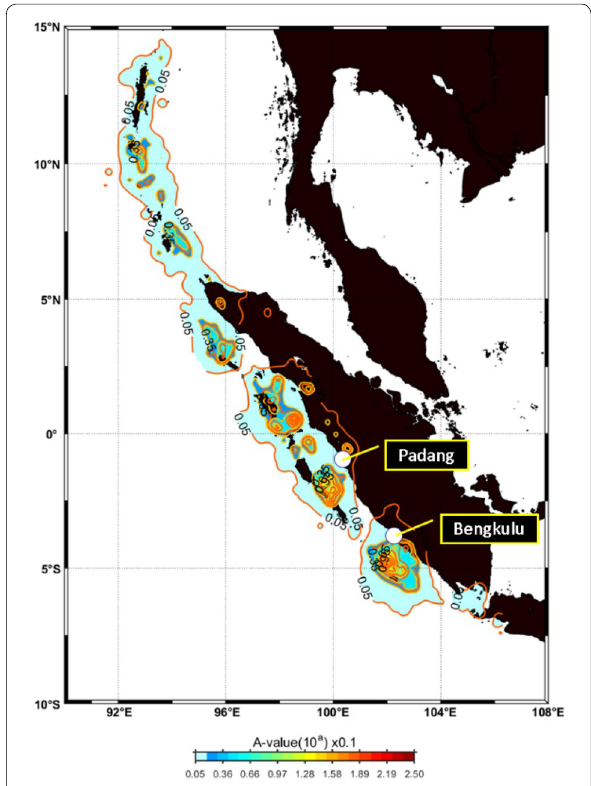
Fig. 2 The A -value model, estimated by product of normalized seismic moment rate with mean seismicity smoothing and a correlation distance of 25 km, 50 km, and 150 km of M w H 50-km of the years 1963 to ≤